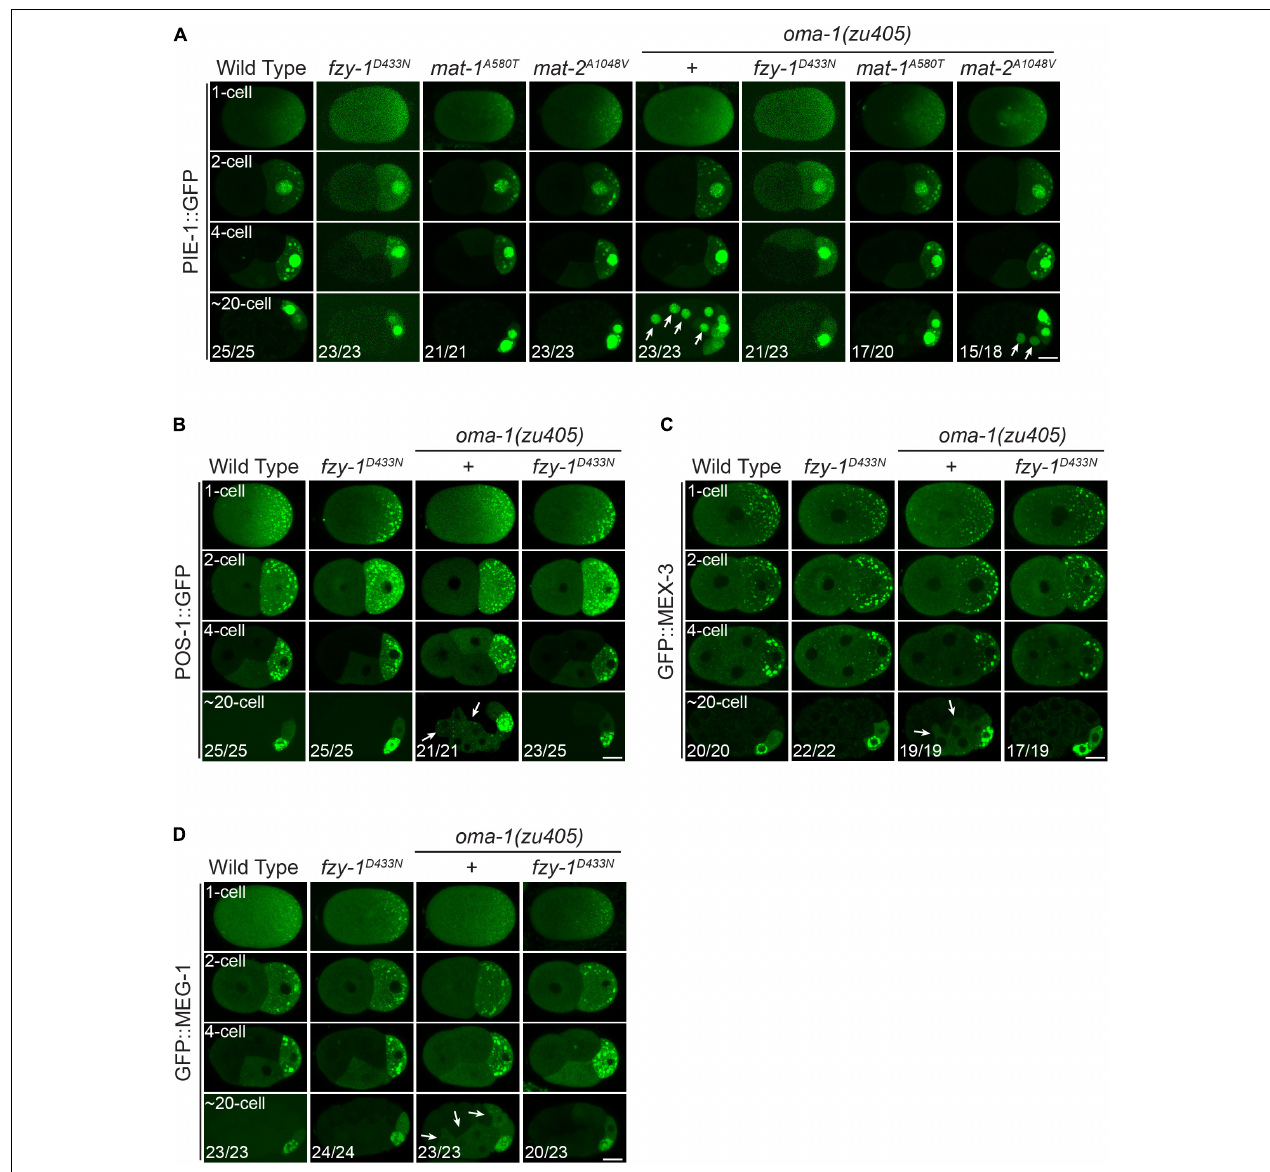
FIGURE 6 | Mutants of APC/C genes correct the disrupted distribution of downstream cell fate determinants of OMA-1 in the oma-1(zu405) mutant. (A) Fluorescent micrographs show the localization of PIE-1::GFP in 1-cell, 2-cell, 4-cell, and ∼ 20-cell stage embryos in the wild type, fzy-1 D 433 N , mat-1 A 580 T , and mat-2 A 1048 V mutants, with or without oma-1(zu405) in the background. Arrows indicate abnormal localization of PIE-1::GFP in somatic cells. (B) Fluorescent micrographs show the localization of POS-1::GFP in 1-cell, 2-cell, 4-cell, and ∼ 20-cell stage embryos in the wild type and fzy-1 D 433 N mutants, with or without oma-1(zu405) in the background. Arrows indicate abnormal localization of POS-1::GFP in somatic cells. (C) Fluorescent micrographs show the localization of GFP::MEX-3 in 1-cell, 2-cell, 4-cell, and ∼ 20-cell stage embryos in the wild type and fzy-1 D 433 N mutants, with or without oma-1(zu405) in the background. Arrows indicate abnormal localization of GFP::MEX-3 in somatic cells. (D) Fluorescent micrographs show the localization of GFP::MEG-1 in 1-cell, 2-cell, 4-cell, and ∼ 20-cell stage embryos in the wild type and fzy-1 D 433 N mutants, with or without oma-1(zu405) in the background. Arrows indicate abnormal localization of GFP::MEG-1 in somatic cells. All phenotypes in 1-, 2-, and 4-cell embryos were 100% penetrant. Scale bar: 10